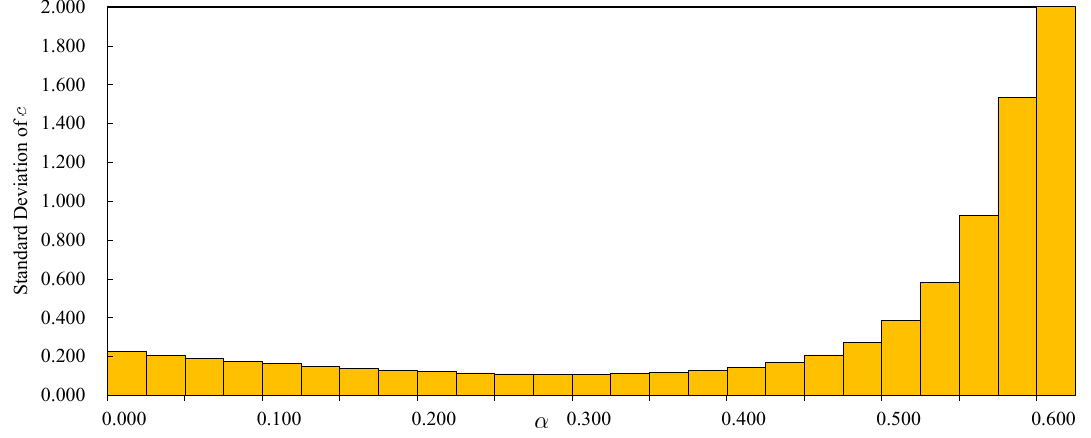
Figure 7 . The standard deviation of c = m tower / | Λ | α for each α in the case of isotropic non-SUSY vacua. The range of α shown in the figure is set as [0 . 000 , 0 . 600] and the increments are 0.025. In this figure, α = 0 . 275 gives the minimum value 1 . 18 × 10 − 2